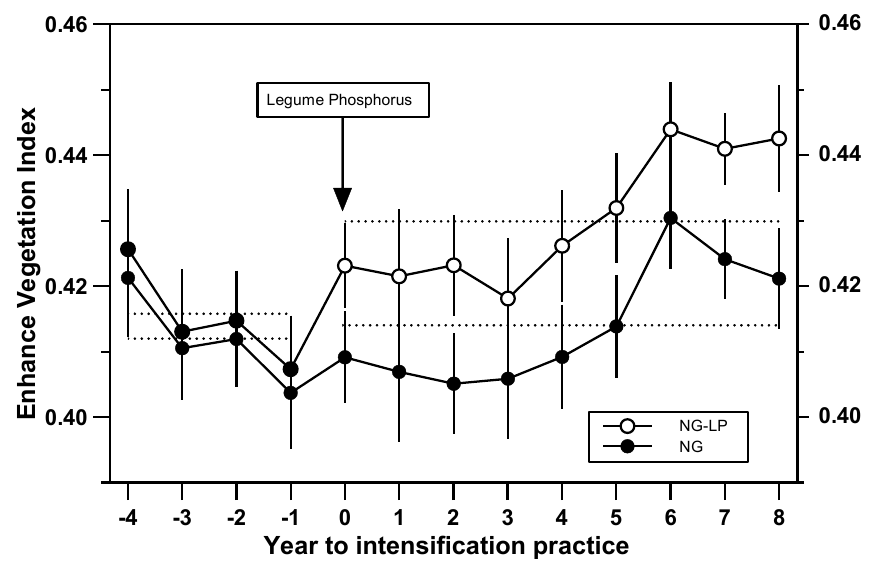
Figure 2. Mean Enhanced Vegetation Index (EVI) of natural grassland four years before, and natural grassland (NG) and natural grassland overseed with legumes and fertilized with phosphorus (NG- LP), over nine years after intensification practice (year 0, arrow inside the panel). Each circle corresponds to mean annual EVI of 20 paddocks, error bars indicate one spatial standard error between paddocks, and dotted horizontal lines interannual EVI mean (before intensification practice, F = 0.6, p value = 0.45; after intensification practice, F = 18.9, p value < 0.05). The intra-annual EVI mean was similar between paddocks before intensification practice (F = 0.75, p value = 0.40), showing a seasonal pattern (F = 12.4, p value < 0.0001) that was not affected by intensification practice (F = 0.85, p value = 0.59, Table A5). In contrast, over nine years of the intensification practice, mean winter–spring EVI of NG- LP was 7.5% higher than that of NG (significant interaction; T = 4.2, p value < 0.05), while the maximum difference was 9.7% in August, and null difference was in January and Feb- ruary (Figure 3; Table A6).